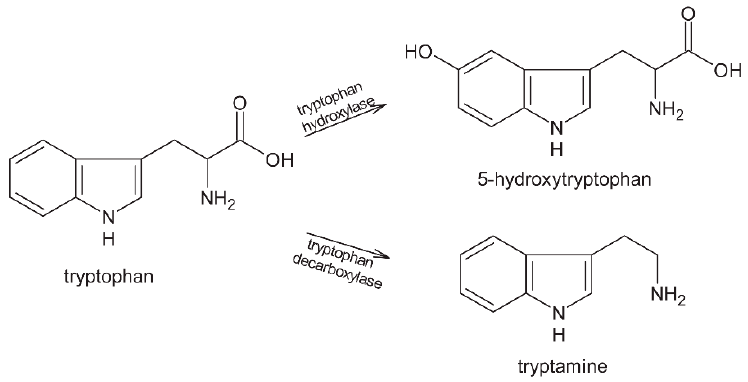
Figure 1. Possible transformation of tryptophan during fermentation of cocoa beans.